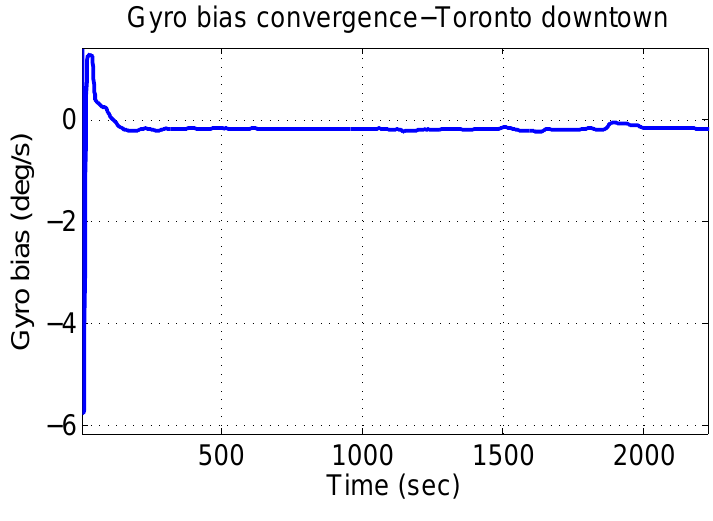
Figure 21. Convergence of gyroscope bias during the Toronto downtown